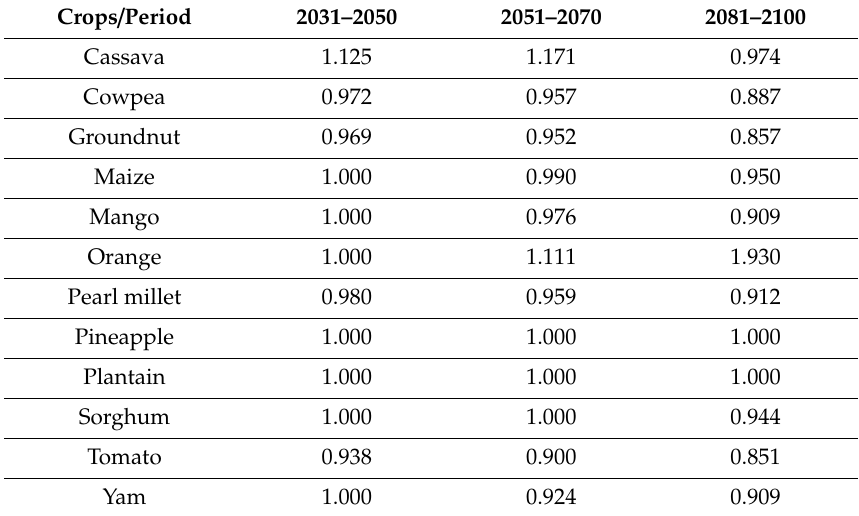
Table 5. Trends in the projected change in the month of planting over West Africa for the near future, mid and end of the century periods for the di ff erent